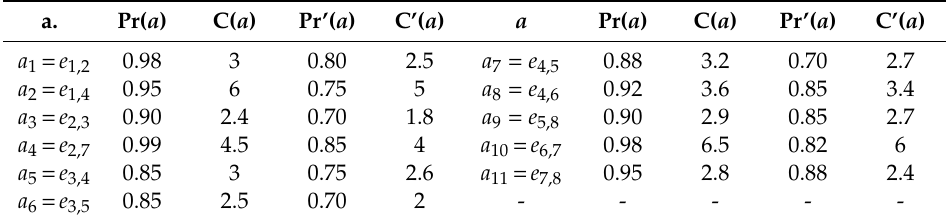
Figure 5. The wildfire detection sensor network. Table 8. Arc success probability and recovery cost in Figure